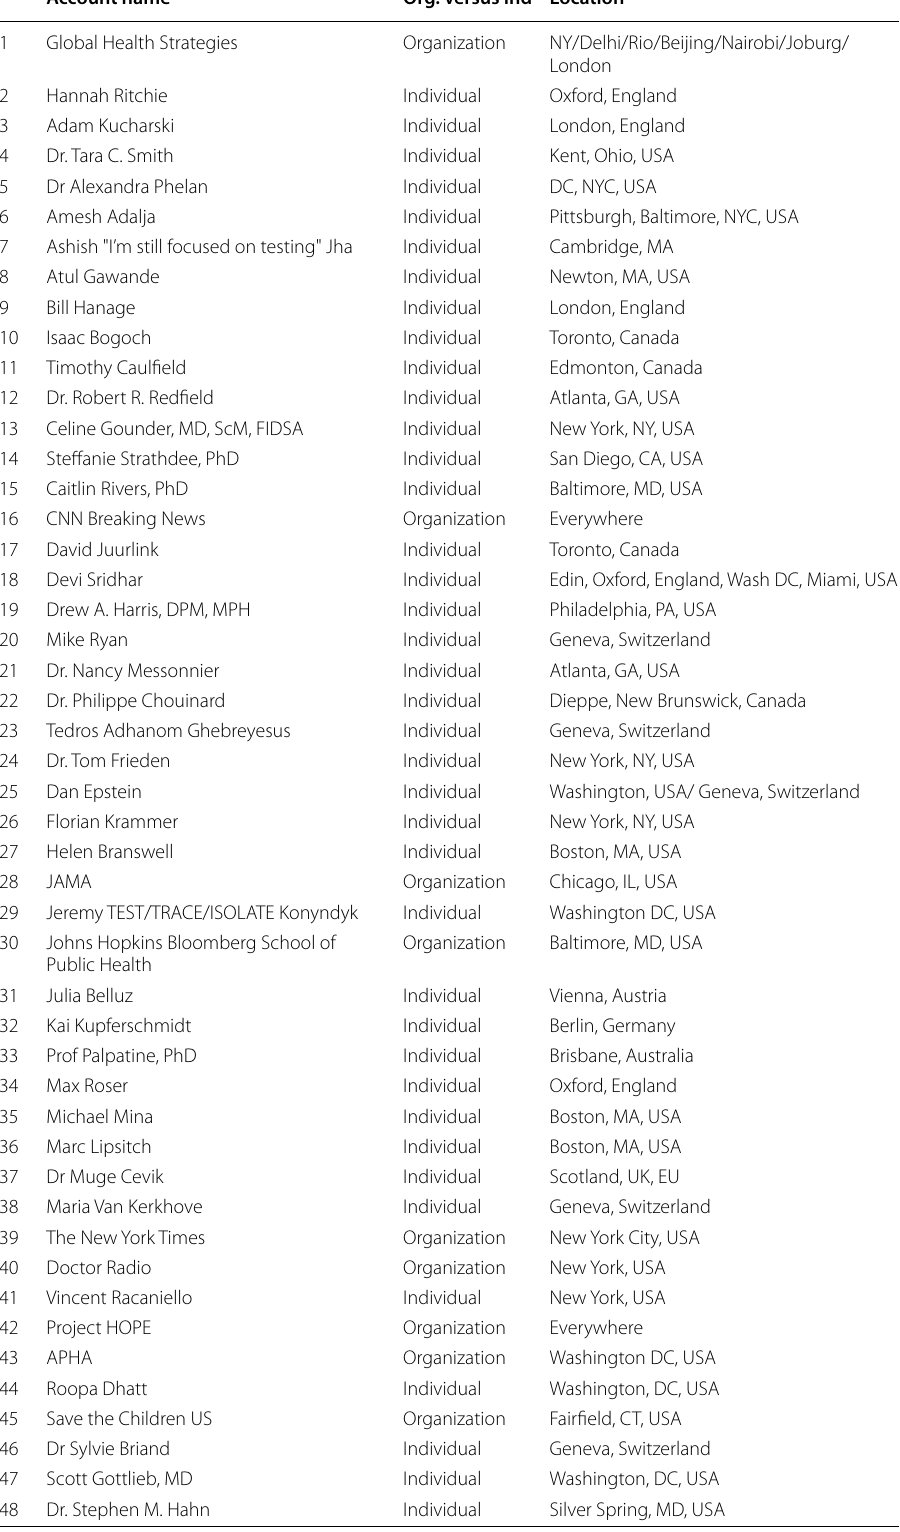
Table 5 Selected twitter accounts of trusted officials and individuals related to